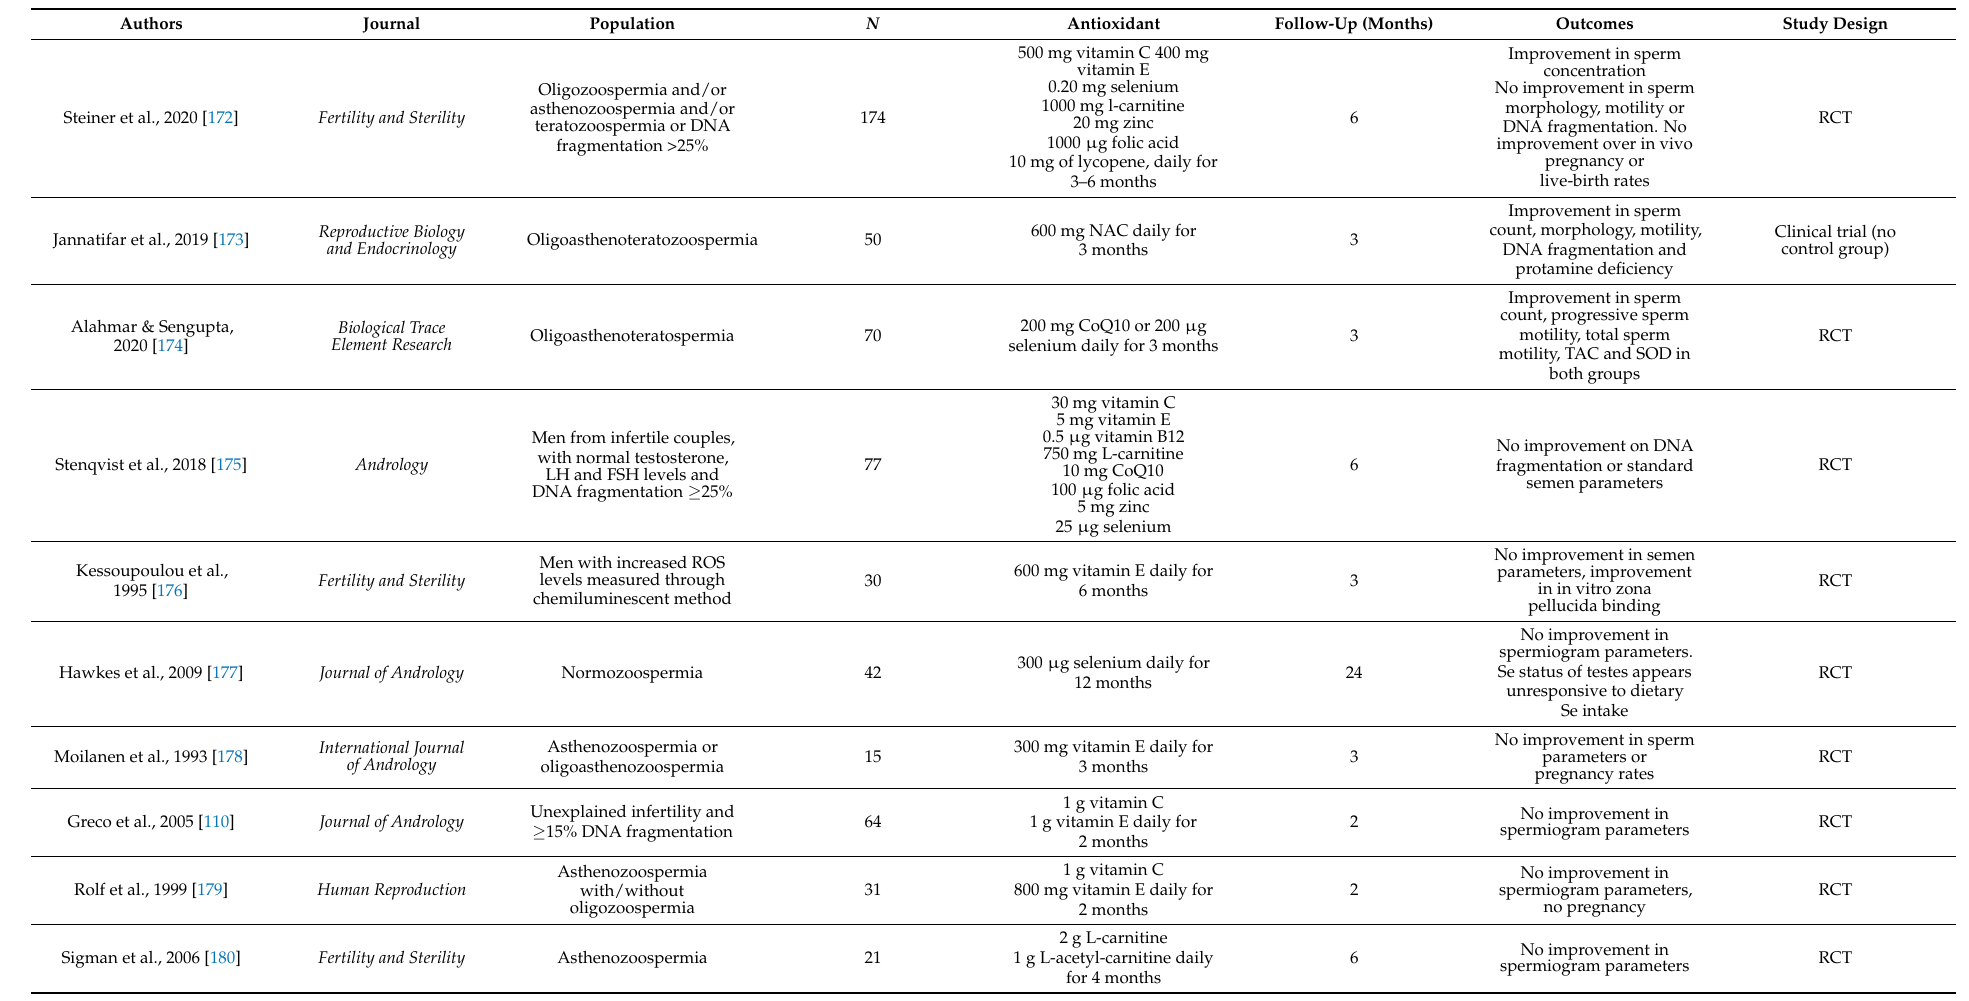
Table 1. Studies regarding the use of antioxidants for male infertility. RCT: randomized controlled trial; TAC: total antioxidant